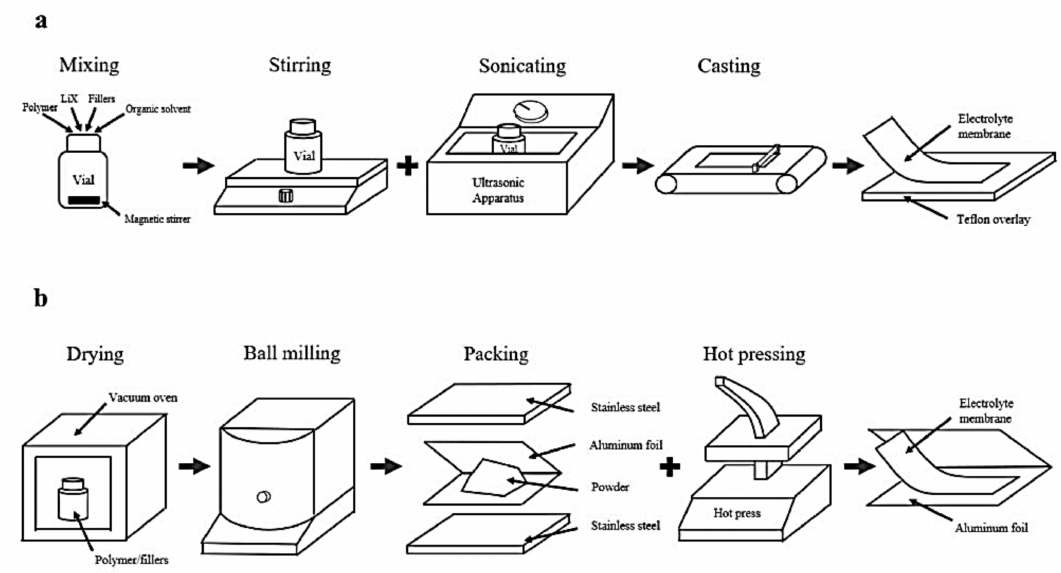
Figure 9. Schematic procedures for preparing solid polymer electrolytes by ( a ) solvent casting technique and ( b ) thermo- compression. Reproduced with permission from Nano Converg., 8, Feng et al.PEO based polymer-ceramic hybrid solid electrolytes: a review, 2, 2021